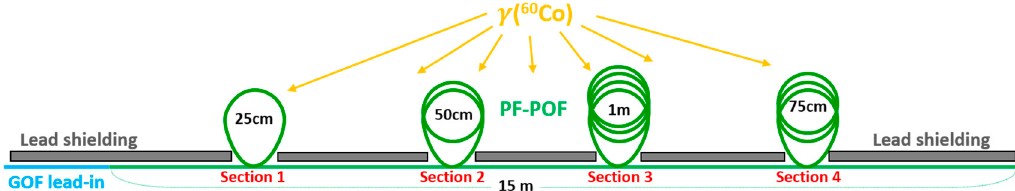
Figure 6. Schematic illustration of experimental configuration used for distributed fiber irradiation and RIA measurement. Four fiber sections to be irradiated are positioned at an equal distance from the 60 Co source and are irradiated simultaneously under the same conditions.